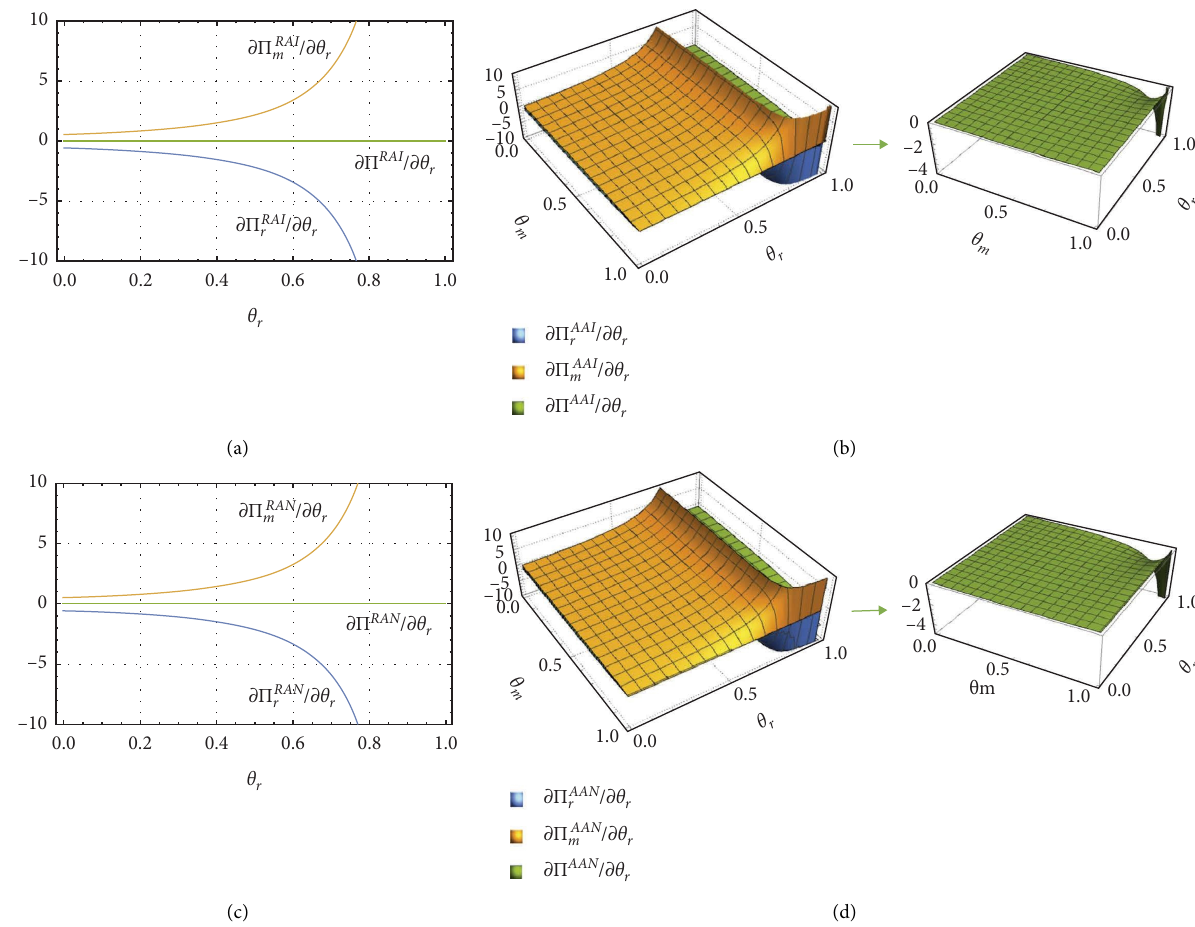
Figure 9: Infuence of the retailer’s altruistic preference on profts ( a � 1 , b � 0 . 5 ,c � 0 . 2 , c � 1 ) . (a) In scenario RAI. (b) In scenario AAI. (c) In scenario RAN. (d) In scenario AAN.